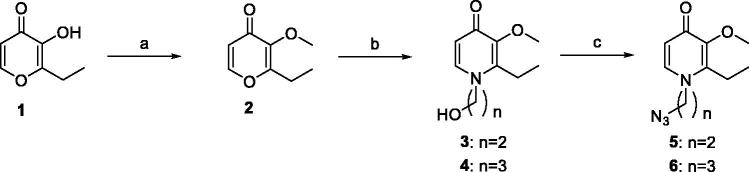
The synthetic route of intermediates 5 and 6. Reagents and conditions: (a) Acetone, CH3I, K2CO3, r.t., 4 h, 93%; (b) MeOH:H2O = 1:1, NH2(CH2)nOH, NaOH, reflux, 12 h, 81%–83%; (b) DMF, NaN3, Ph3P, CBr4, r.t., 1 h, 75%–86%.